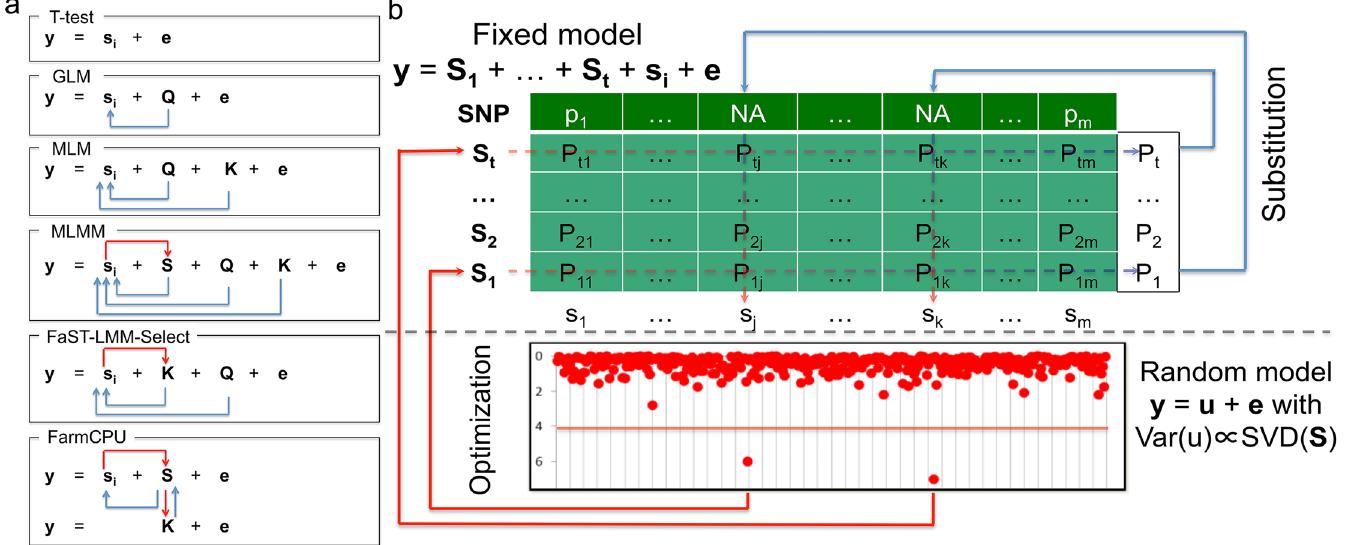
Fig 1. Conceptual development and procedure of FarmCPU. The proposed method, FarmCPU, was inspired by the method development demonstrated on the left panel (a) . These methods start with a na ï ve model (e.g. t-test) that tests marker effect, one at a time, i.e. i th marker (s i ), on the phenotype ( y ) with a residual effect ( e ). Next, GLM controls false positives by fitting population structure ( Q ) as covariates to adjust the test on genetic markers indicated by the blue arrows. MLM fits both Q and kinship ( K ) as covariates. However, both Q and K remain constant for testing all the markers. Neither Q nor K receives adjustment from association tests on markers. MLMM add pseudo QTNs as additional covariates ( S ). These pseudo QTNs are estimated through a stepwise regression procedure. Consequently, these pseudo QTNs receive adjustment from association tests on markers as indicated by the red arrow. However, both Q and K remain constant for testing all the markers. Although similar to MLM, FaST-LMM-Select controls false positives by fitting Q and K as covariates; the K of FaST-LMM-Select is incorporated with association tests on markers as indicated by the red arrow. However, Q remains constant. FarmCPU completely removes the confounding between the testing marker and both K and Q by combining MLMM and FaST-LMM-Select, but allowing a fixed effect model and a random effect model to perform separately. The fixed effect model contains the testing marker and pseudo QTNs to control false positives. The pseudo QTNs are selected from associated markers and evaluated by the random effect model, with K defined by the pseudo QTNs. The fixed effect model and random effect model are used iteratively until a stage of convergence is reached, that is, when no new pseudo QTNs are added. The right panel (b) displays the fixed effect model above the dashed line and the random effect models below the dashed line. The t pseudo QTNs ( S 1 to S t ) are fitted as covariates to test markers one at a time, e.g., i th marker ( s i ) in the fixed model. As the pseudo QTNs are fitted as covariates for each marker, Not Available (NA) is assigned as the test statistic for all markers that are also pseudo QTNs — as the genetic marker is completely co-linear to the pseudo QTN marker. However, each pseudo QTN has a test statistic corresponding to every marker, creating a matrix (lightly shaded) with elements of P ij , i = 1 to t and j = 1 to m. The most significant P value of each pseudo QTN (the vector on the right of shaded area) is used as the substitution for the NA of the corresponding marker. The pseudo QTNs are optimized by using the SUPER method in the random model to incorporate both test statistics from the fixed effect model and genetic map information in the genotype data. The random effects are the individuals ’ genetic effects ( u ) with variance and covariance matrix, Var( u ), defined by the Singular Value Decomposition (SVD) on the pseudo QTNs by using the FaST-LMM algorithm. The updated set of pseudo QTNs go back into the fixed model. The process continuously repeats until no more pseudo QTNs are